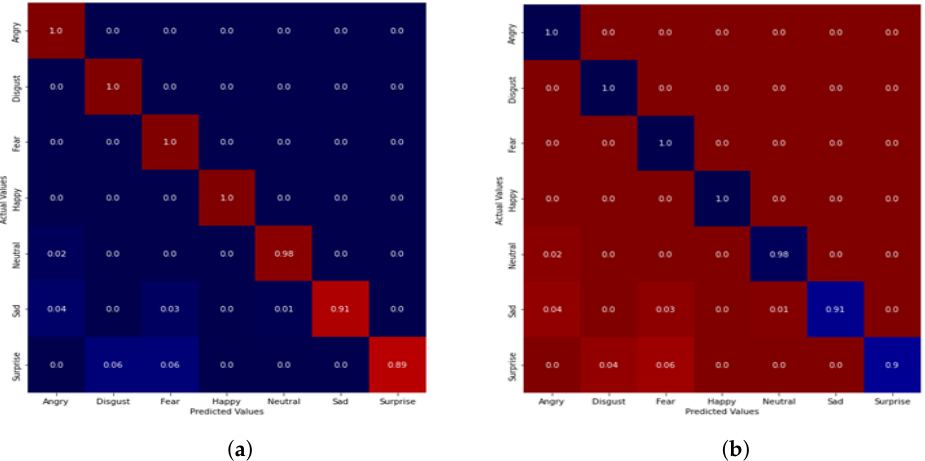
Figure 4. Confusion matrix of emotion classification on TESS dataset. ( a ) DCNN-NCA-MLP. ( b )